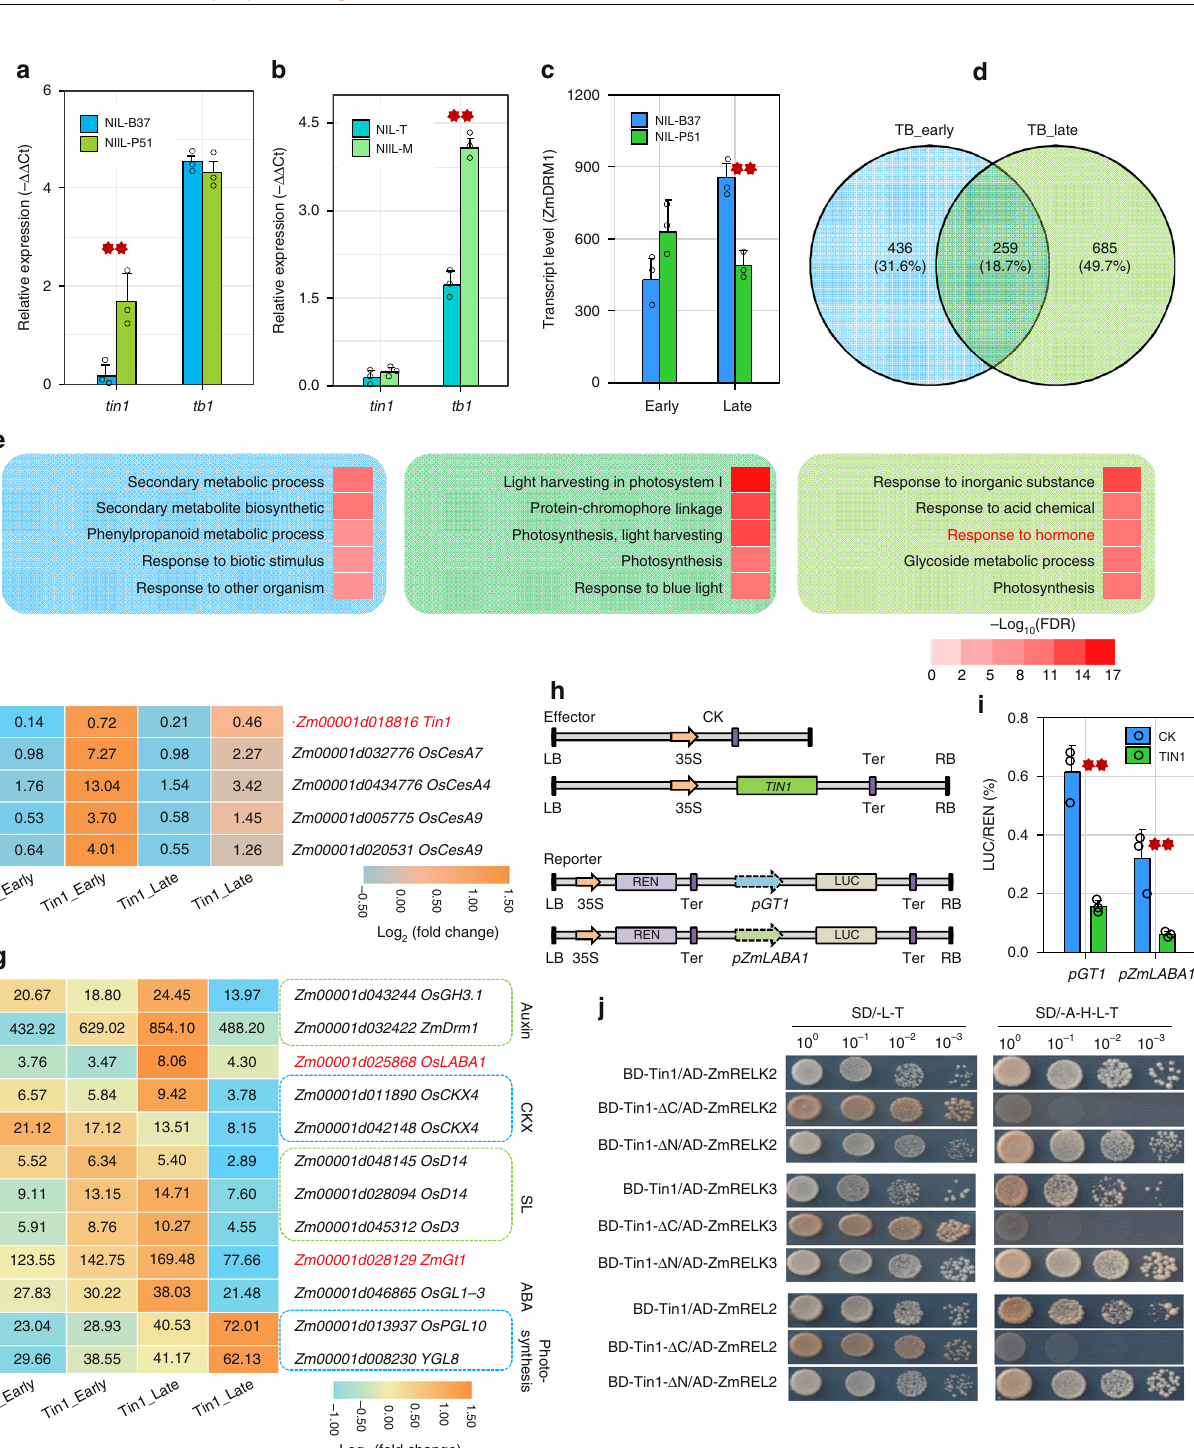
RT-qPCR (Supplementary Fig. 11). We next selected eight of these genes, and performed dual-luciferase transient expression assays in maize protoplasts to test the effect of tin1 on their expression (Fig. 5h and Supplementary Fig. 12). In rice, Laba1 20 (also named as An-2 21 ) controls awn, tiller number and yield. Overexpression of tin1 (effector) signi fi cantly suppressed the activity of the luciferase (reporter) activity driven by the gt1 and Laba1/An-2 promoters (Fig. 5i), indicating that the TIN1 protein directly targeted the promoters of gt1 and Laba1/An-2 and then suppressed transcriptions during maize tiller bud outgrowth.